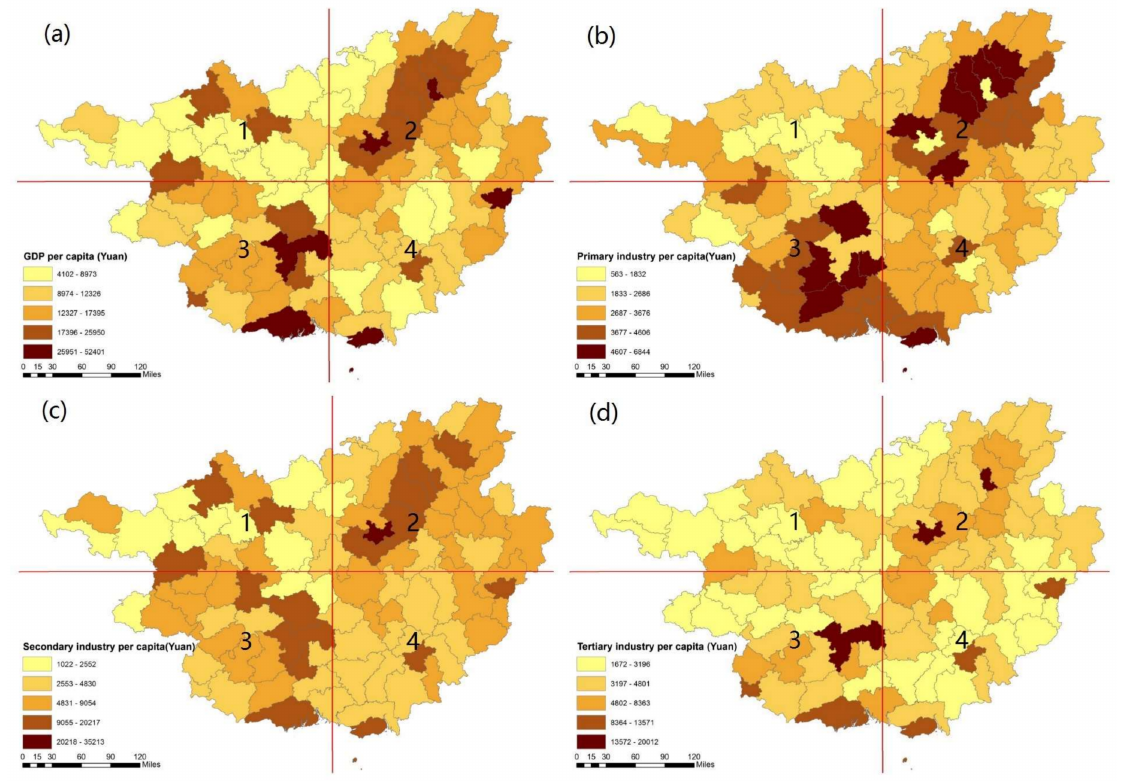
Figure 5. The spatial distribution of economic indicators in Guangxi ( a – d